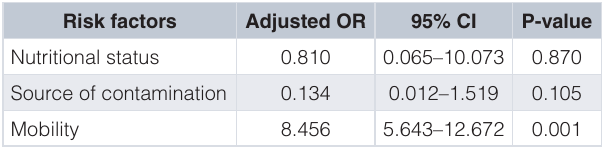
Table 3. Results of logistic regression for risk factors of diphtheria. Risk